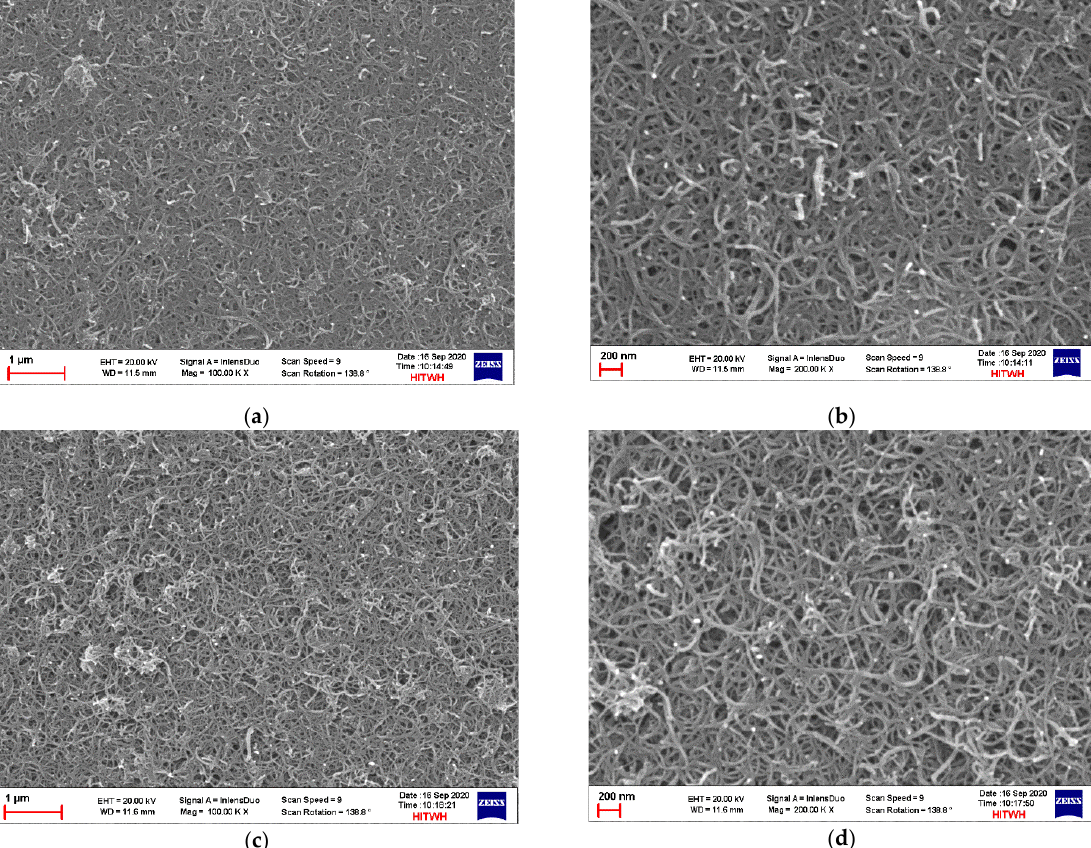
Figure 3. FESEM images of MWCNTs/PVDF conductive membrane: Surface morphology of MWCNTs/PVDF conductive composite membrane before crosslinking with 1 µ m ( a ) and 200 nm ( b ); Surface morphology of crosslinked MWCNTs/PVDF conductive composite membrane with 1 µ m ( c ) and 200 nm ( d ).